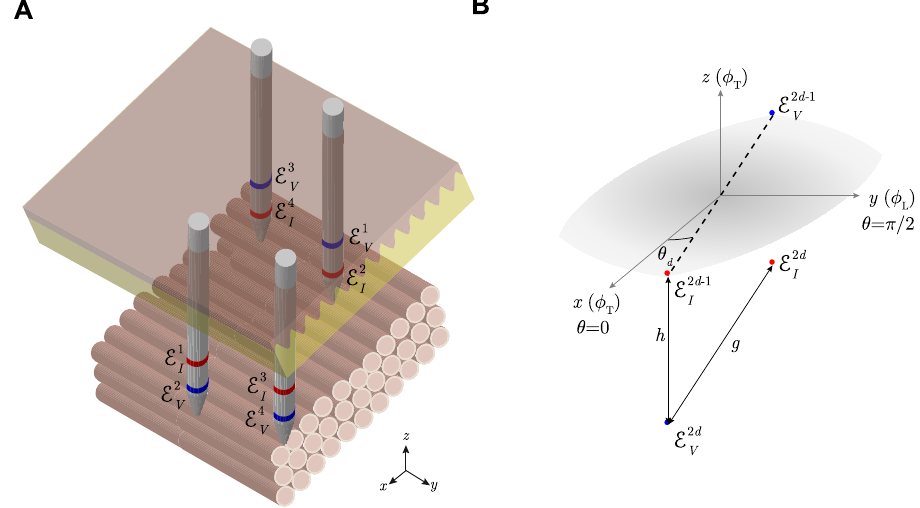
Figure 12. ( A ) Schematic showing the in situ measurement of anisotropic permittivity in D = 2 angles using multipolar needles. N.b. compared to Fig. 11, the pairs of current and voltage electrodes have different coordinates in the z -direction (in red and blue color, respectively). ( B ) Schematic of the d -th angle measured in the xy -plane ( z = 0). The measurement angle θ d is defined with respect to the muscle fibers’ transverse (T) { x , z } direction φ T (i.e. φ T = θ when θ = 0) and φ L is the longitudinal y direction. Electrode configuration:  − Id 2 1 , source current electrode; Vd 2 1  − , high potential electrode;  Vd 2 , low potential electrode; Id 2  , sink current electrode; where d D 1, 2, ,  = is the number of different angles measured from 0 to π